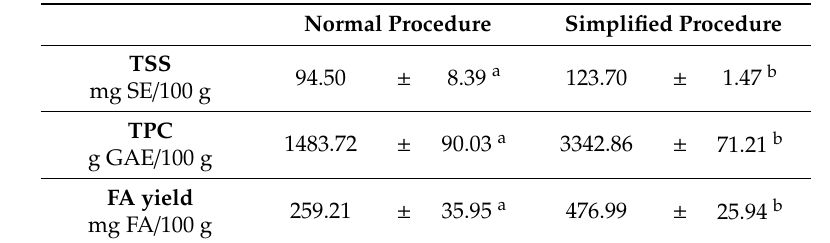
a indicates not significant di ff erences and b indicates significant di ff